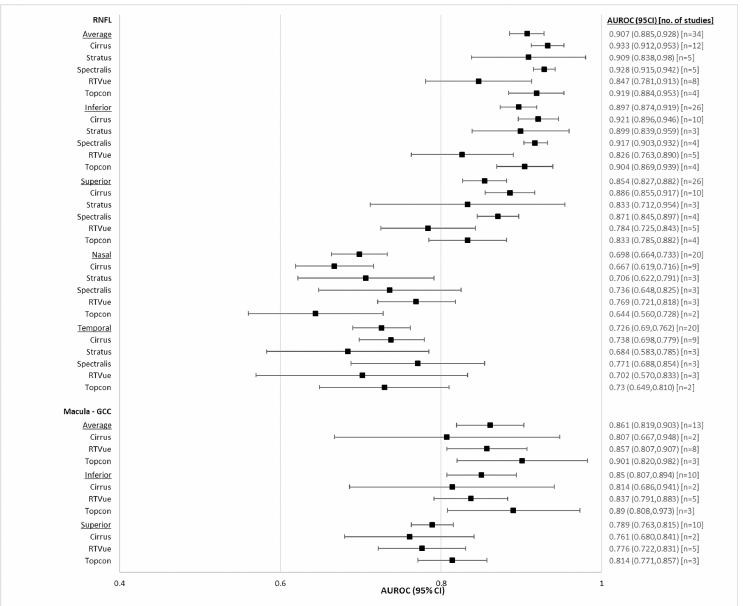
Fig 6. Forest plot of diagnostic accuraciesof RNFL and macular OCT parameters, mild